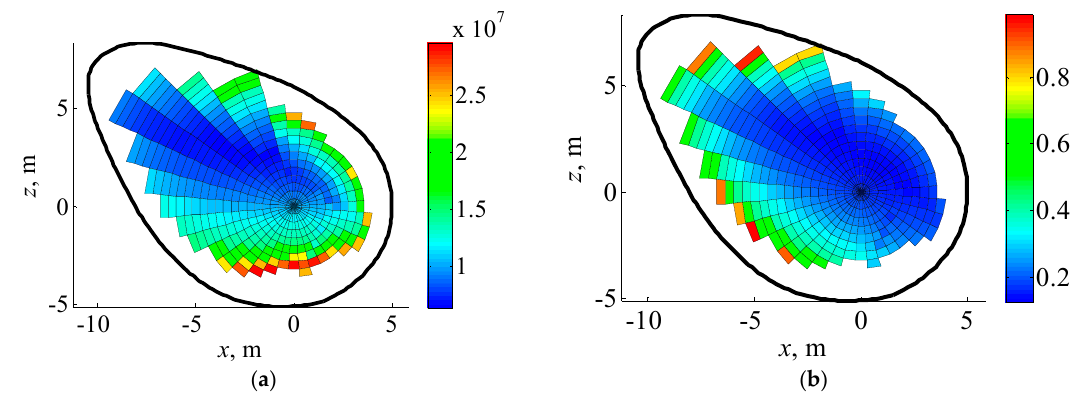
Figure 15. Distribution of the lowest movable mass weight and corresponding mass ratio at different designed positions: ( a ) lowest movable mass weight; and ( b ) corresponding mass ratio.